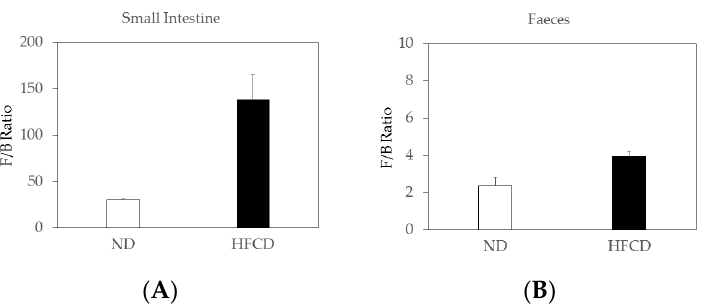
Figure 2. Firmicute -to- Bacteroidetes ratio ( F/B ratio) was calculated from the sequence-read number as a biomarker of gut dysbiosis. Comparison of microbiota composition in small intestines ( A ) and feces ( B ) in stroke-prone spontaneously hypertensive-5 (SHRSP5) rats fed normal diet (ND) or high- fat- and high-cholesterol-containing diet (HFCD).